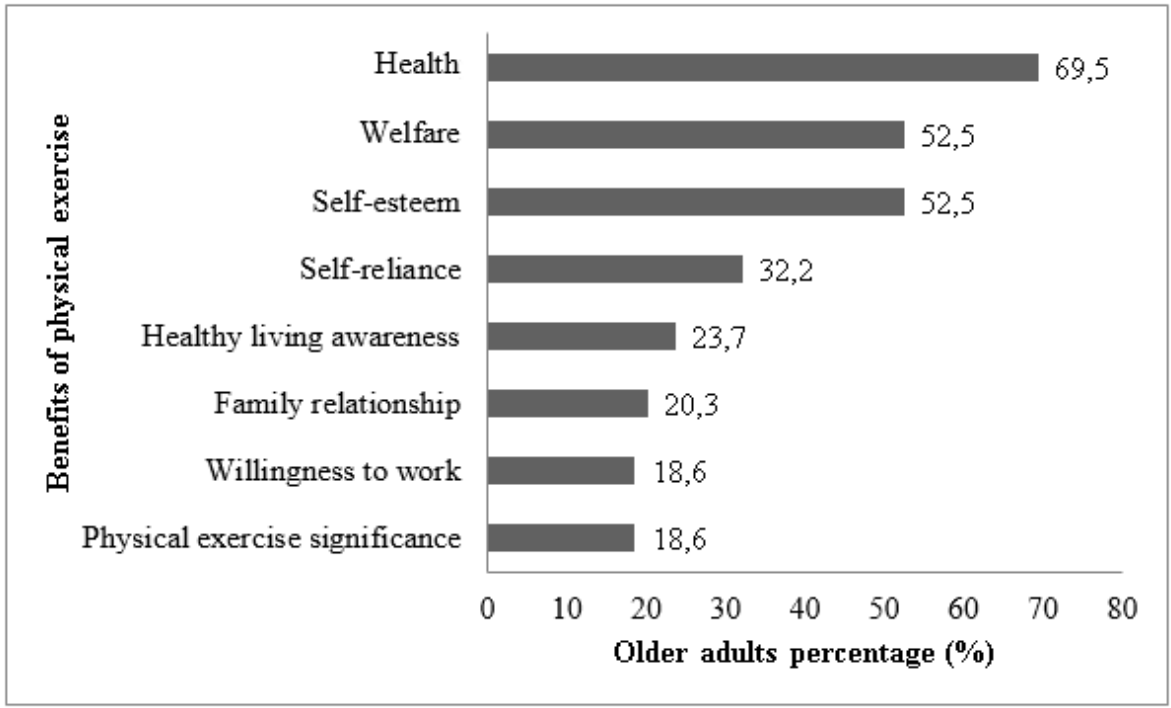
Figure 4 - Benefits of practicing physical exercise during participation in the